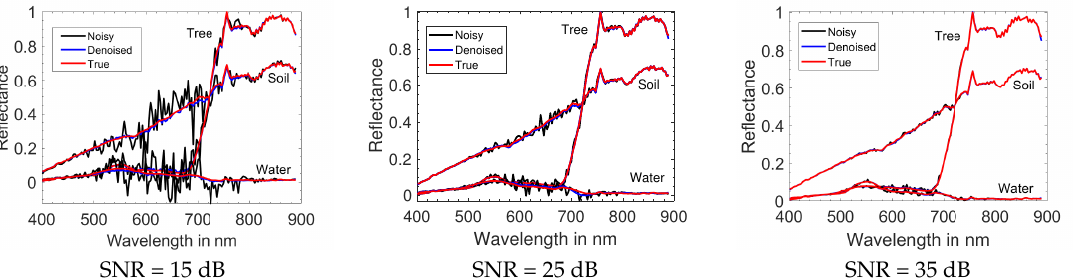
Figure 10. The ground truth endmembers and the endmembers extracted by the simplex volume maximization technique (SiVM), without and with prior denoising of the Samson image using HyRes, in the cases of colored noise ( η =